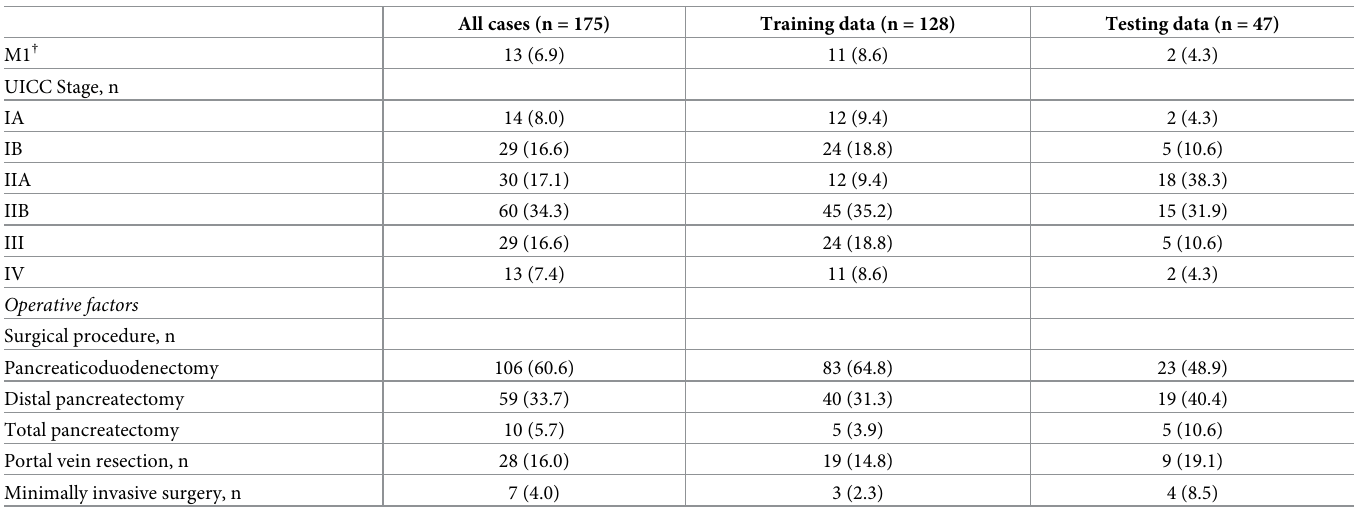
Binary logistic regression indicated that ALT and surgical procedure (DP) were significant predictors of massive IBL occurrence (Chi-Square = 48.977, df = 12, and p < 0.001). All twelve predictors explained 32.5% of the variability of massive IBL occurrence. The results of Hosmer and Lemeshow was p = 0.347. ALT and surgical procedure (DP) were significant at the 5% level (ALT Wald = 4.829, p = 0.028; DP Wald = 7.454, p = 0.006). The odds ratio for ALT was